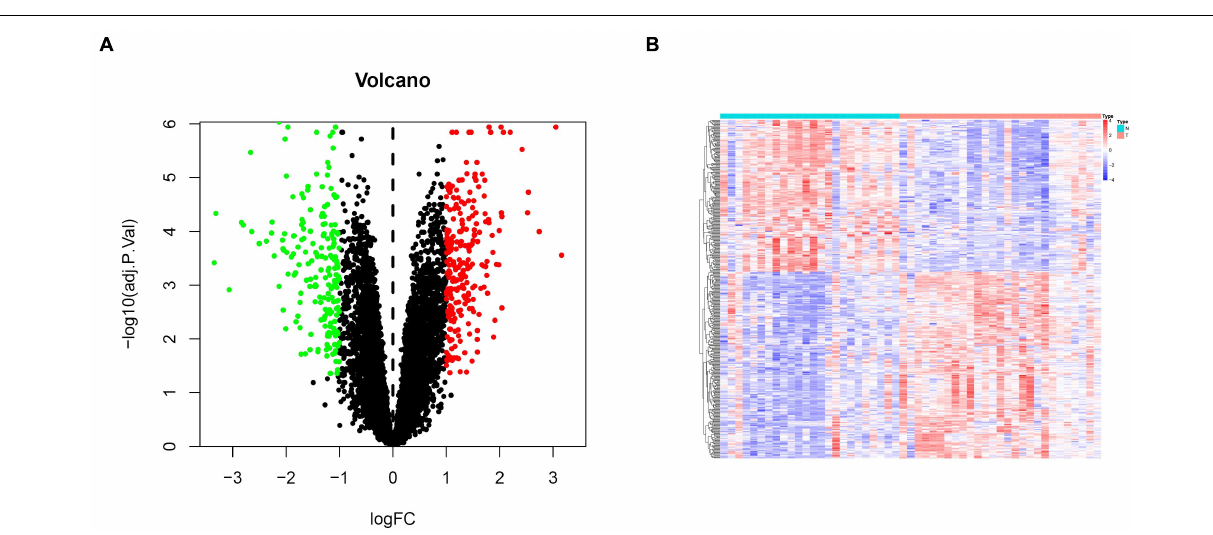
FIGURE 2 | Differential gene expression analysis in endometriosis cases. (A) Volcanic plots for differentially expressed genes. Red and green dots denote significantly upregulated and downregulated genes, respectively, while black dots indicate non-significant genes. (B) A heat map showing profiles of the differentially expressed